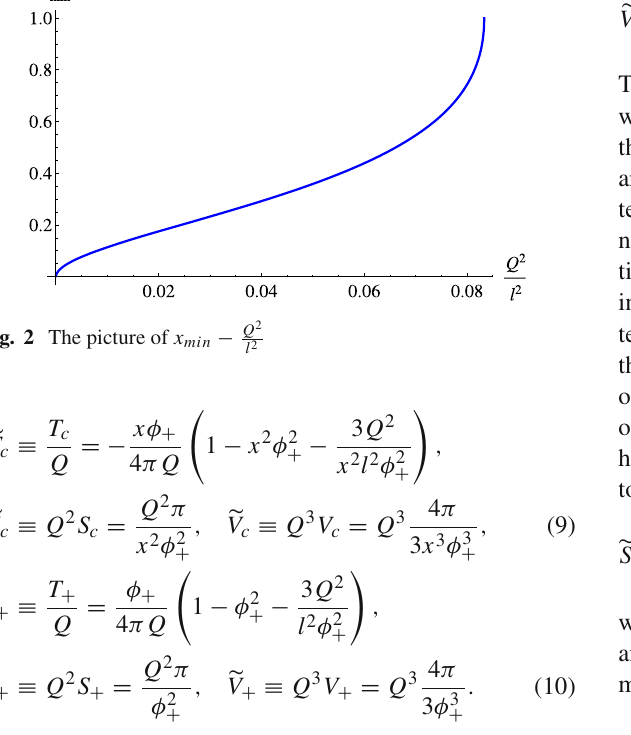
Fig. 2 The picture of x min − Q 2